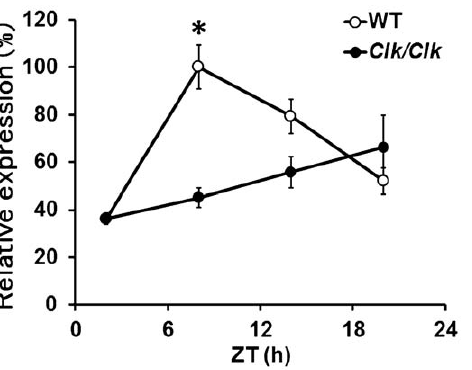
Figure 1. Clock mutation damps daily variation in C/ebp a mRNA expression. Total RNA was extracted from the livers of three wild-type (WT; open symbols) and three Clock mutant ( Clk ; closed symbols) mice maintained under a 12 h light/12 h dark cycle (lights on at 0:00 and lights off at 12:00) and then C/ebp a expression was determined by RT-PCR. Maximal value for wild-type mice is expressed as 100%. Each time point comes from average of three mice. Data are presented as mean 6 SEM (n=3, *: p , 0.01).